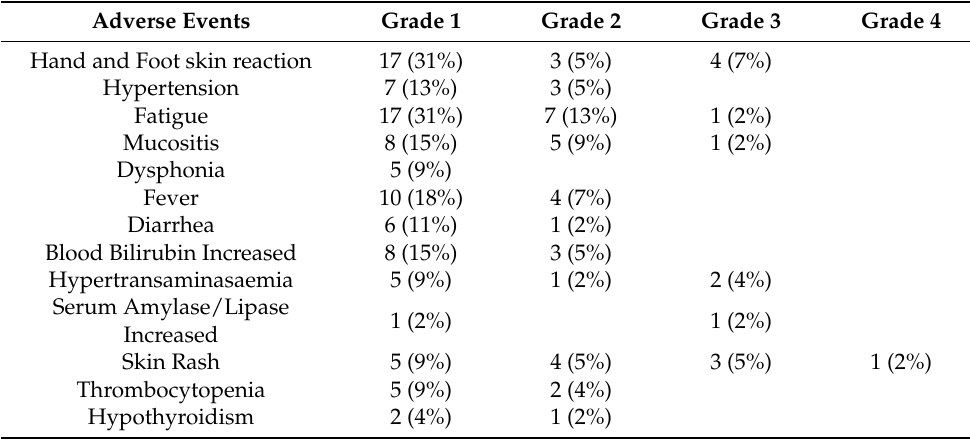
Table 5. Drug-related adverse events according to the CTCAE v 5.0. Adverse Events Grade 1 Grade